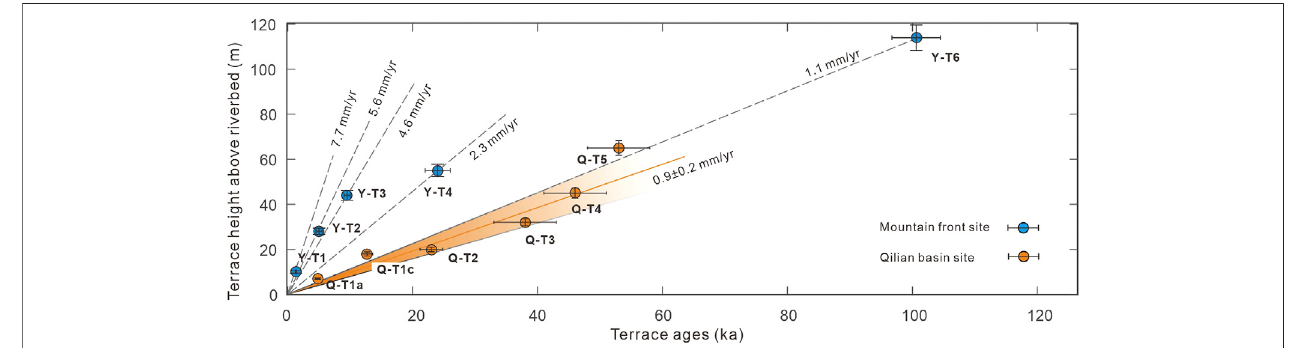
FIGURE7| Plotofagesversustheheightsofthedifferentterraces.Thebluebarsindicatetheageerrors.Therateof0.9±0.2 mm/yrisderivedbylinear fi ttingwith 95% con fi dence intervals.